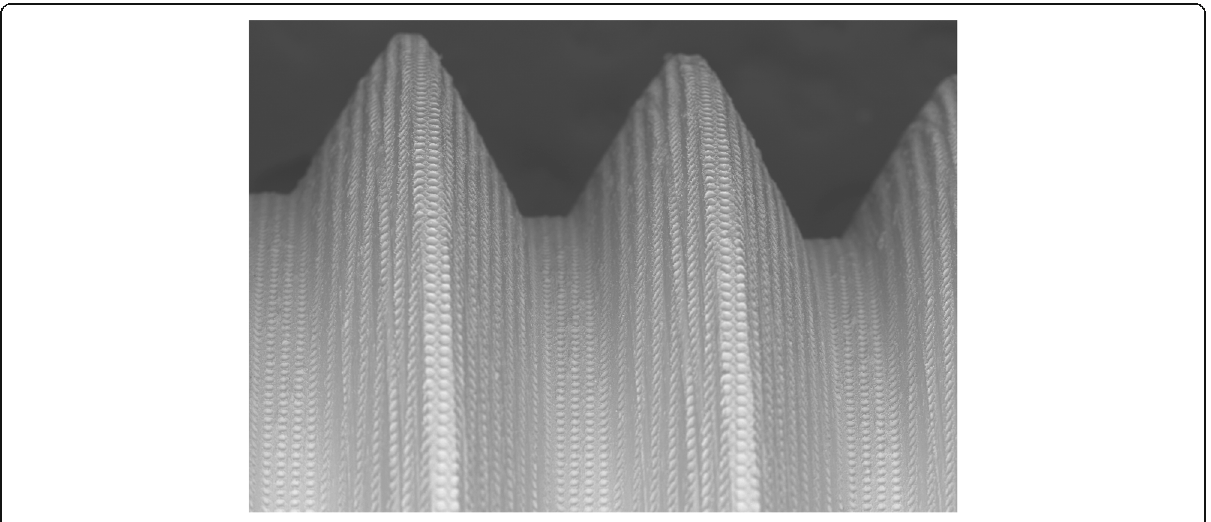
Fig. 2 Scanning electron microscopy picture of group B implant surface